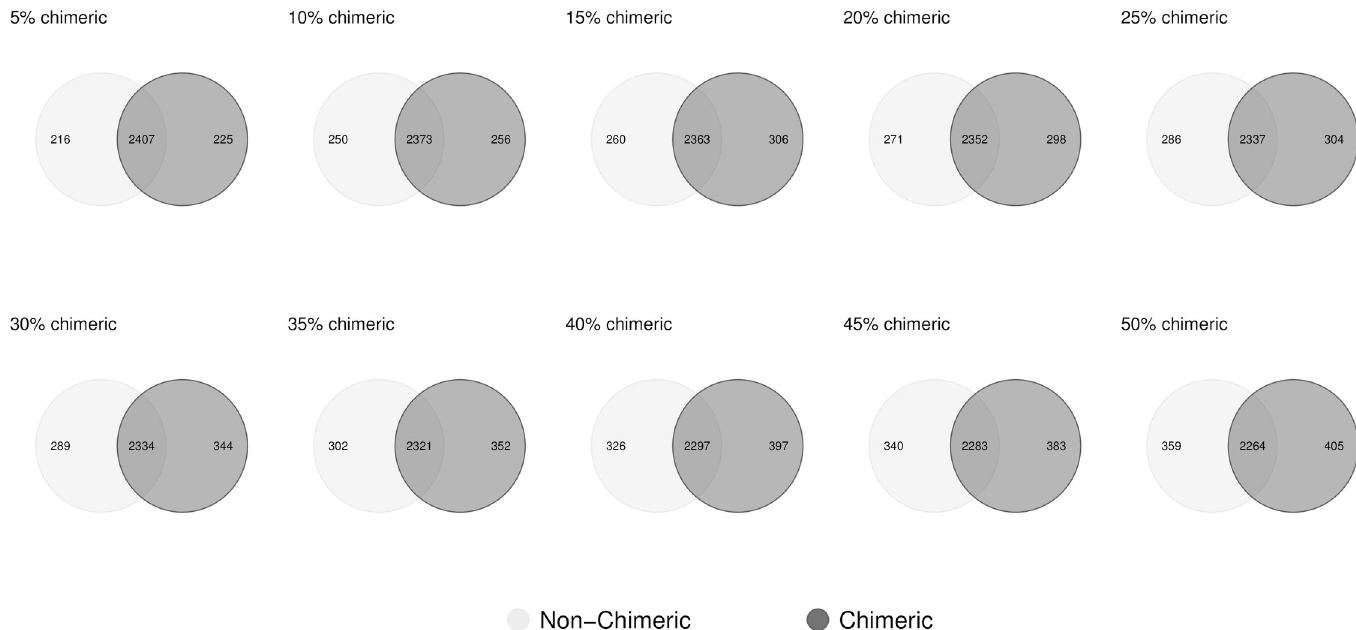
Fig 14. Detection of differentially expressed genes in the presence of chimerism. Light grey circles represent the number of identified differentially expressed genes, between the conditions A and B, that were detected in the absence of chimeric reference transcripts. Dark grey circles represent the number detected in the presence of chimerism, the extent of which is indicated as the percent